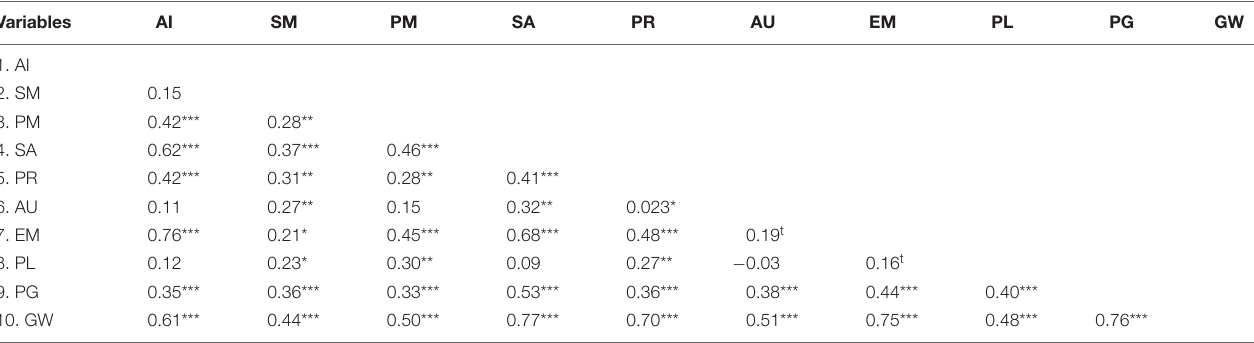
TABLE 2 | Correlations between dimensions of AIS, MLQ, and PWB ( N = 102). Variables AI SM PM SA PR AU EM PL PG